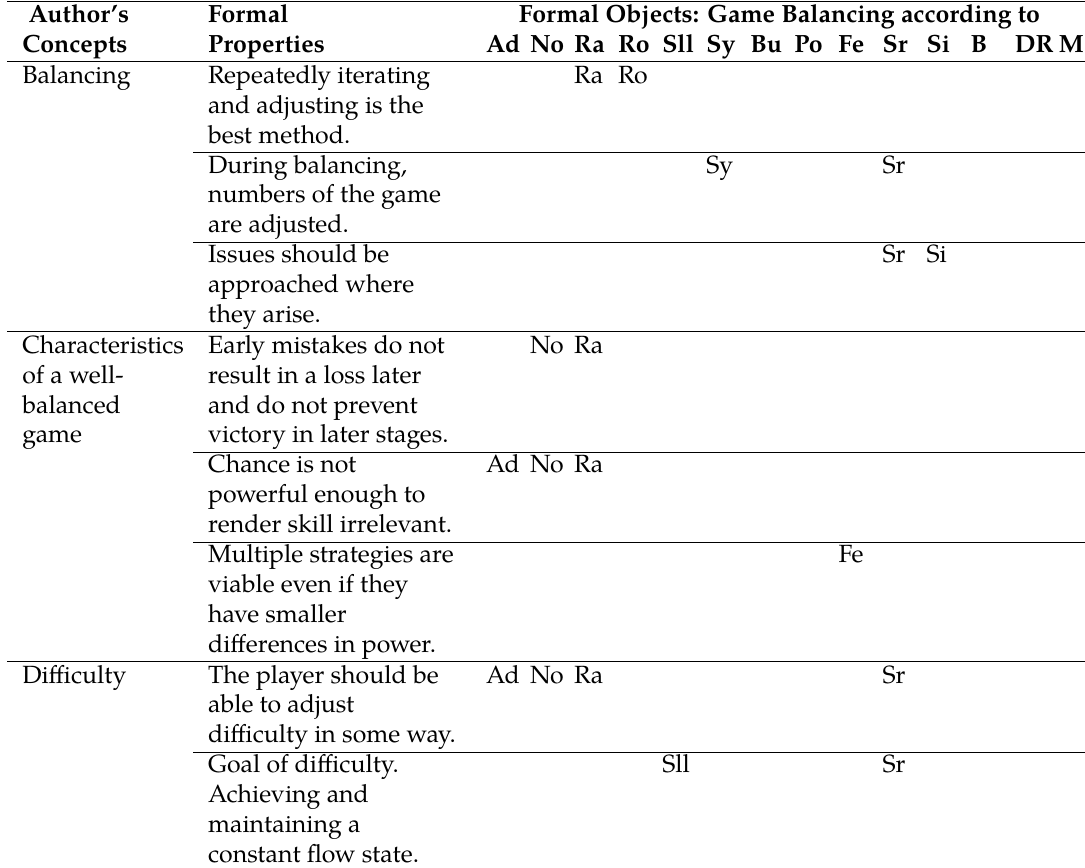
Table 1: Exemplary excerpt from the around 600 entry-long table of formal properties